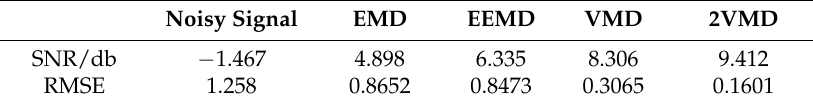
Table 6. The SNR and RMSE for EMD, EEMD, VMD and 2VMD